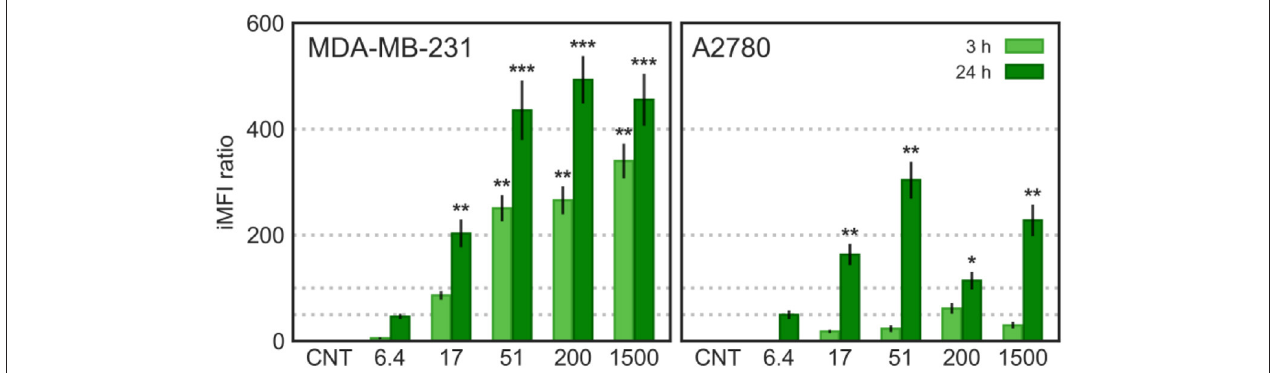
FIGURE 9 | Cytofluorimetric cellular uptake; MDA-MB-231 and A2780 cells were incubated with CNTs and CNT/f-HA-DMPE of increasing HA MW (6.4, 17, 51, 200, and 1,500 kDa) at the same concentration (10 µ g/mL) for 3 and 24h and fluorescence was evaluated on FL-1 channel ( λ ex : 488nm, λ em : 530nm). Statistical significance vs. CNTs: * p < 0.05 ** p < 0.01, *** p < 0.001.